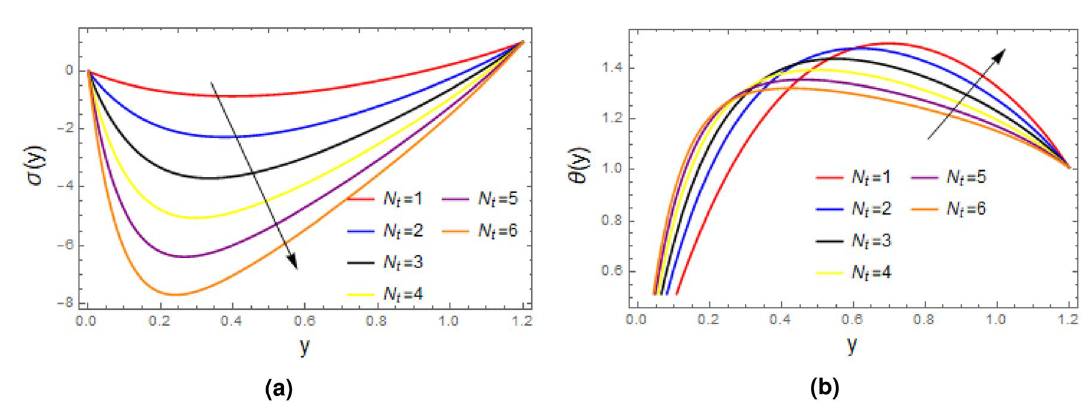
Figure 7. Plots of ( a ) concentration σ and ( b ) temperature θ for different values of thermophoresis parameter with α = 1 , ε = 0.2 , δ = 0.1 , F = 0.5 , x = 1 , Pr = 2 , N b = 0.8 , ζ = 0.01 , Ec = 1 .